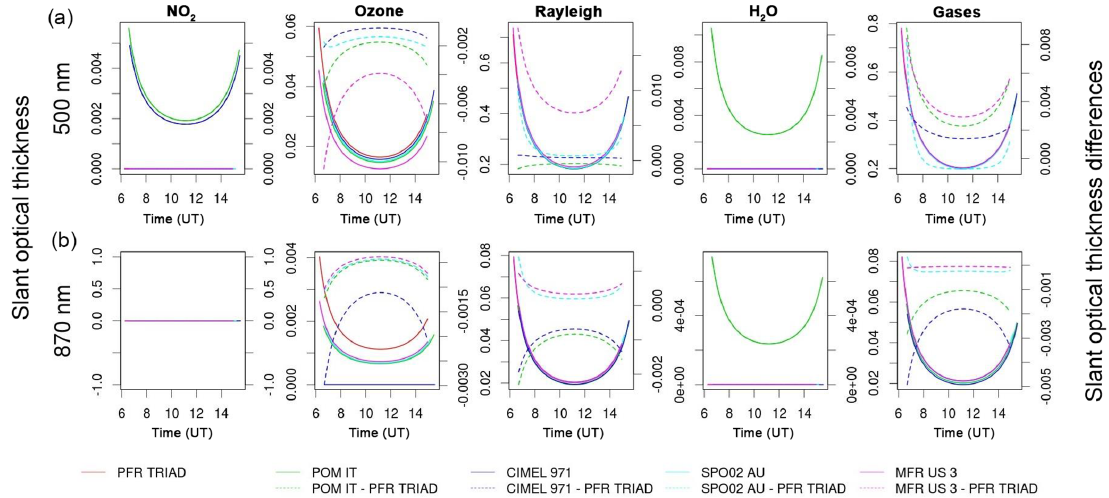
Figure 9. Slant column optical thickness (right axis – thick lines) and optical depth differences compared with the triad (left axis dashed lines), at 500 (a) and 870nm (b)